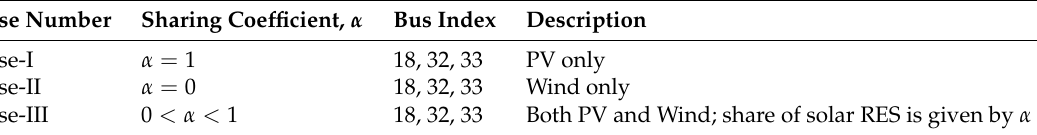
Table 1. System configurations of grid-tied MG.